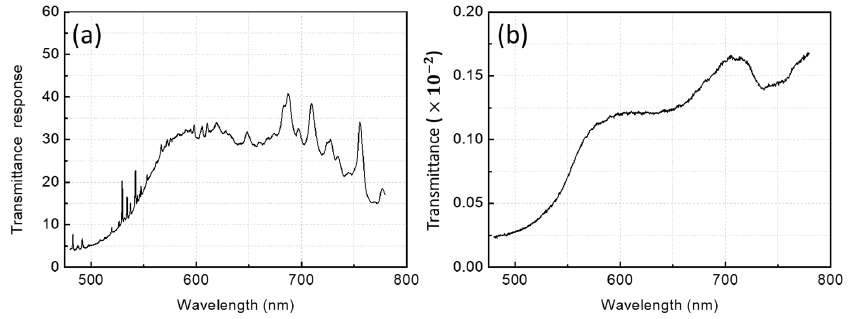
Figure 3. ( a ) Transmission spectrum of a duck egg using xenon flash as a light source. ( b ) Transmittance of a duck egg obtained by dividing the egg transmission response by the spectrum of the light